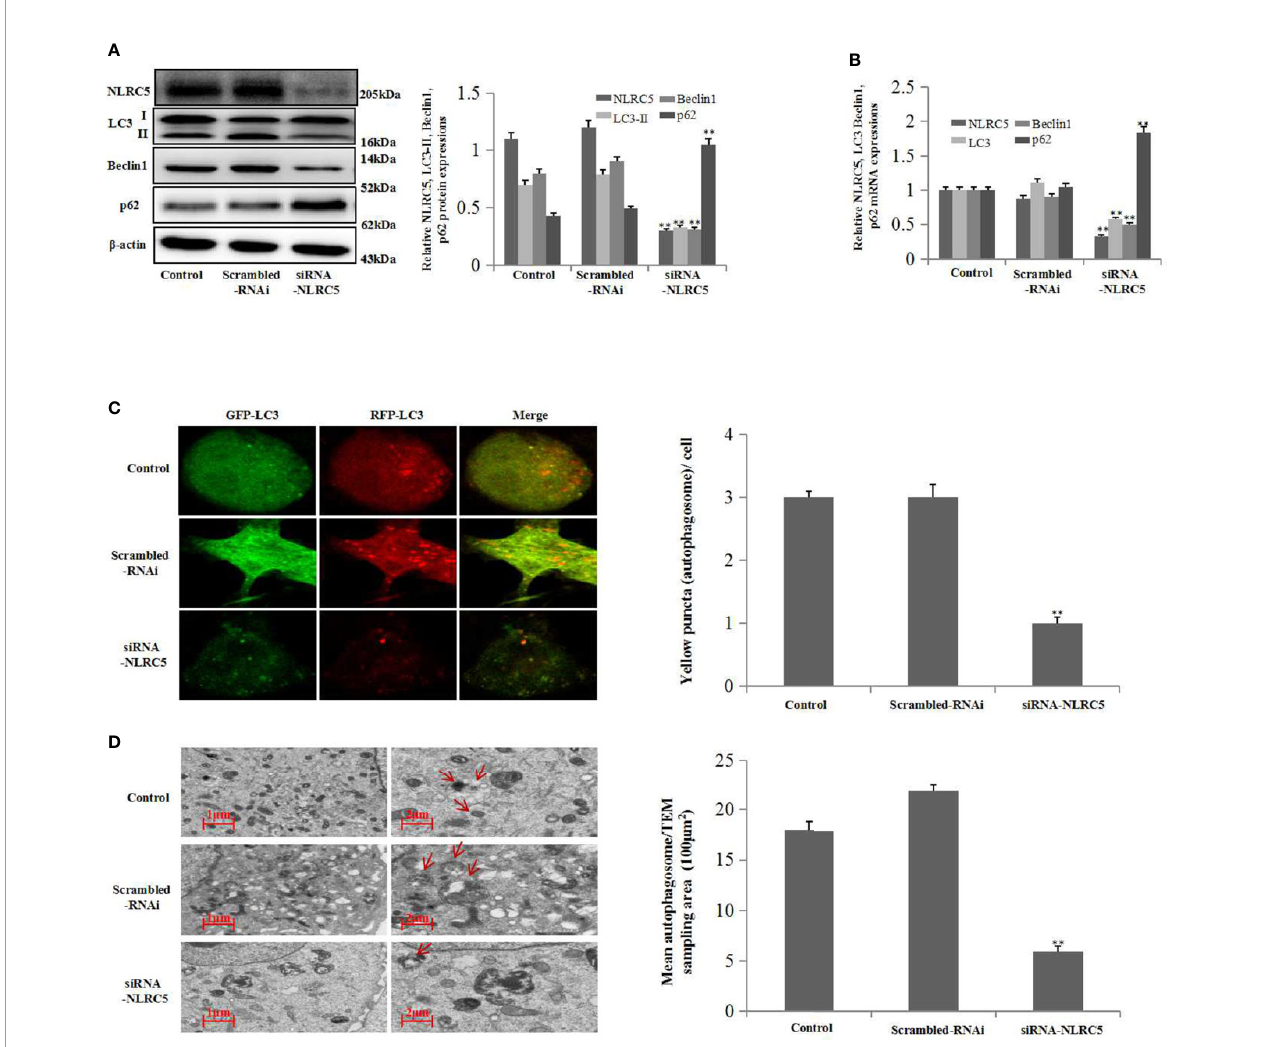
FIGURE 3 | Effects of NLRC5 inhibition on autophagy in EESCs (n = 7). (A , B) Representative western blotting and qRT-PCR results showing inhibition of NLRC5 by transfection with siRNA-NLRC5 signi fi cantly inhibited NLRC5, LC3 Beclin1 expressions, and promoted p62 expression when compared with those from the scrambled-RNAi group (**P < 0.01 vs. scrambled-RNAi group). (C) Representative images showing LC3 staining in EESCs infected with GFP-RFP-LC3 adenovirus; inhibition of NLRC5 by siRNA-NLRC5 transfection signi fi cantly inhibited yellow puncta when compared with scrambled-RNAi group. Photographs were taken at magni fi cations of 1600×, quanti fi cation of mean yellow puncta of 10-15 cells per condition is shown (**P < 0.01 vs. scrambled-RNAi group). (D) Representative TEM image showing inhibition of NLRC5 by siRNA-NLRC5 transfection signi fi cantly inhibited autophagosomes formation when compared with scrambled-RNAi group, autophagosomes were highlighted by red arrows(left scale bar: 1 m m; right scale bar: 2 m m; **P < 0.01 vs. scrambled-RNAi group). The expression levels of mRNA were normalized with respect to b -actin and were calculated using the 2 - DD Ct method. The protein expression levels were quanti fi ed by Image J software and normalized to b -actin protein levels. The results are represented as the mean ± SEM from at least three independent